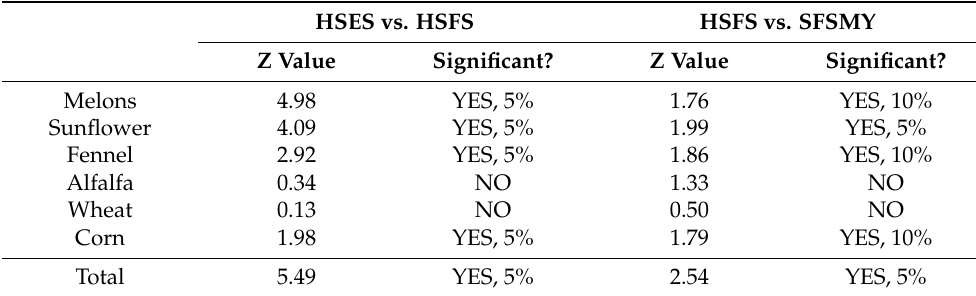
Table 5. Results of McNemar’s test on the crop classification scenarios using different mapping methods. The McNemar’s test for a single crop was conducted in a binary classification system. All of the tests shown were two-sided, and a 10% level significance was